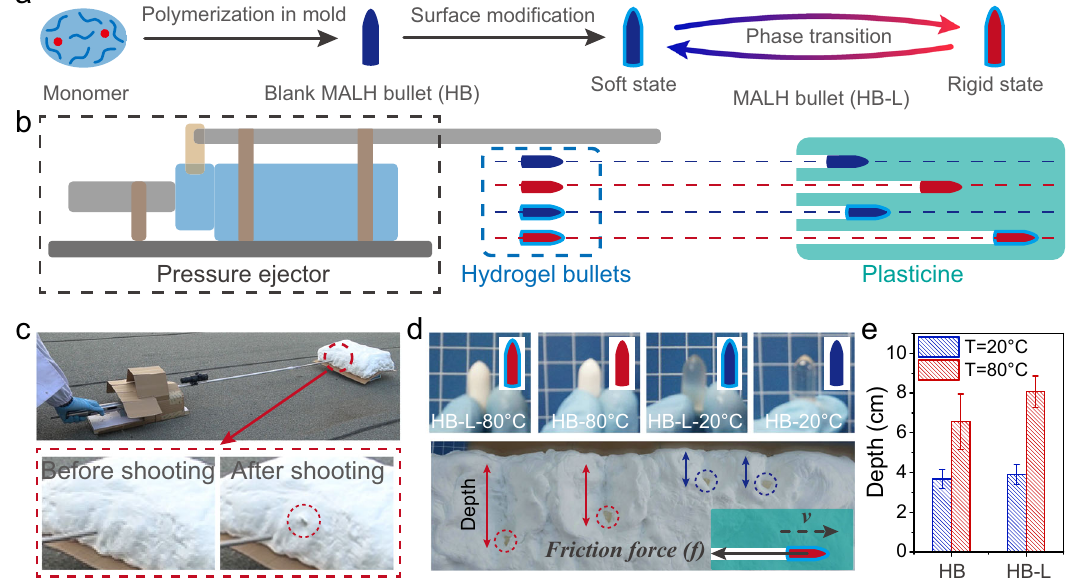
Fig. 5 Demonstration of MALH as intelligent bullets. a Schematic diagram showing the preparation process of MALH bullet. b Schematic diagram showing the shooting experiment at rigid (80 °C) and soft state (20 °C): a home-made a pressure ejector was used as a pistol to shoot the MALH bullet with input energy of ~30 J while the plasticine matrix was acted as base target. c The photo of the shooting ejector and the plasticine before and after shooting. d Optical photos showing the stagnant position of the HB-L and HB at rigid (80 °C) and soft state (20 °C). e The data of penetration depth. The data were presented as mean ± SD and sample size n =